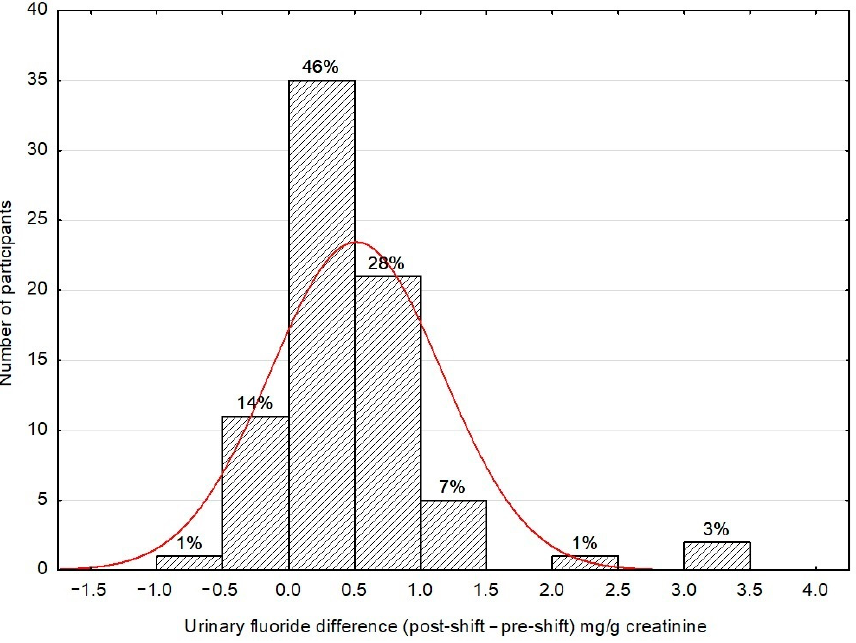
Figure 5. Frequency distribution of urinary fluoride difference for all study participants.